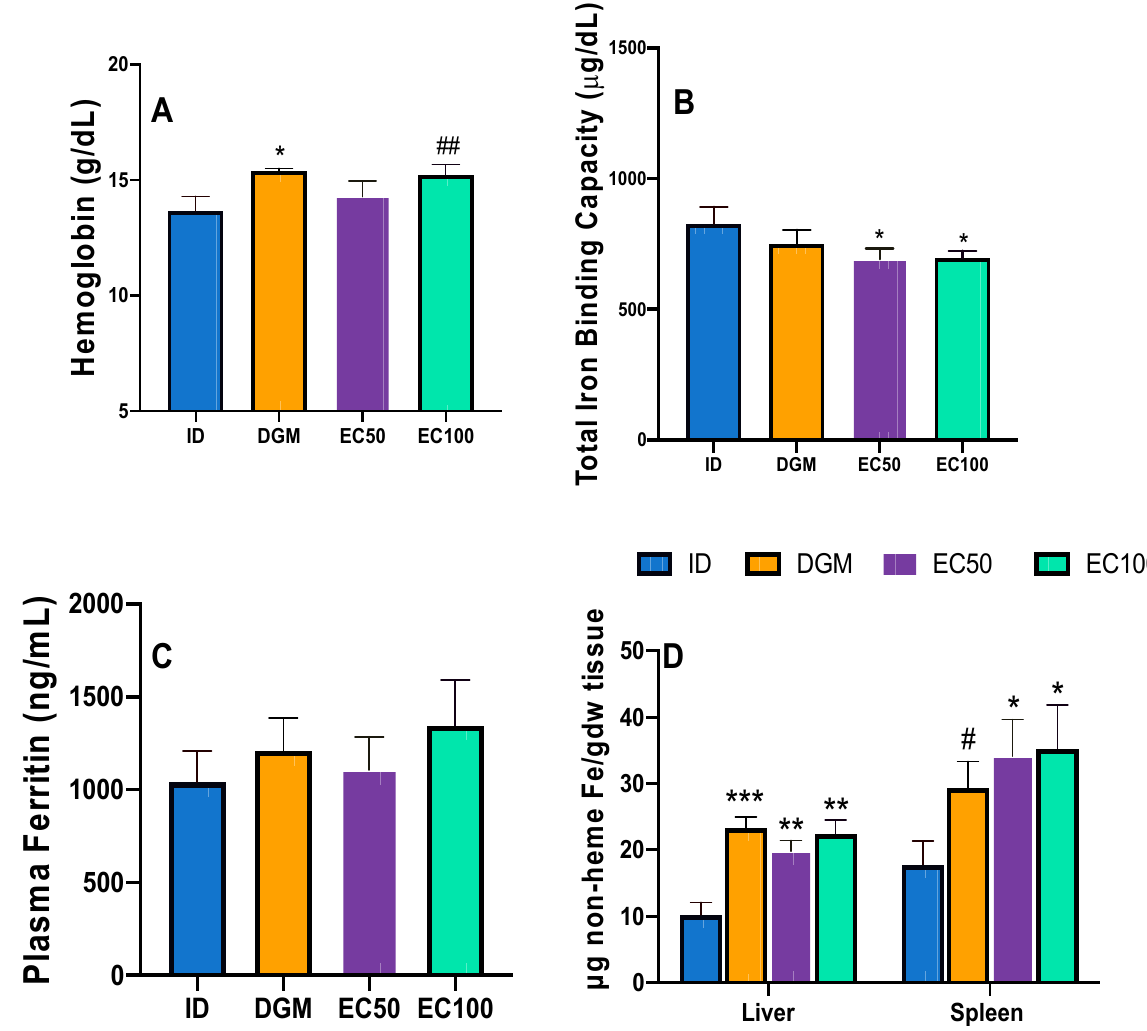
Figure 2. The effects of supplementing control diet (ID) with DGM or encapsulated DGM (EC50, EC100) on ( A ) hemoglobin; ( B ) total iron binding capacity; ( C ) plasma ferritin and ( D ) liver and spleen non-heme iron. Data are expressed as means ± S.E. Means with a * denote significant difference ( p < 0.05) from the control; ** p < 0.01, *** p < 0.001, # p = 0.06, ## p = 0.07, n ≥ 6. Table 3. Growth performance of mice fed different iron ‐ fortified diets *.